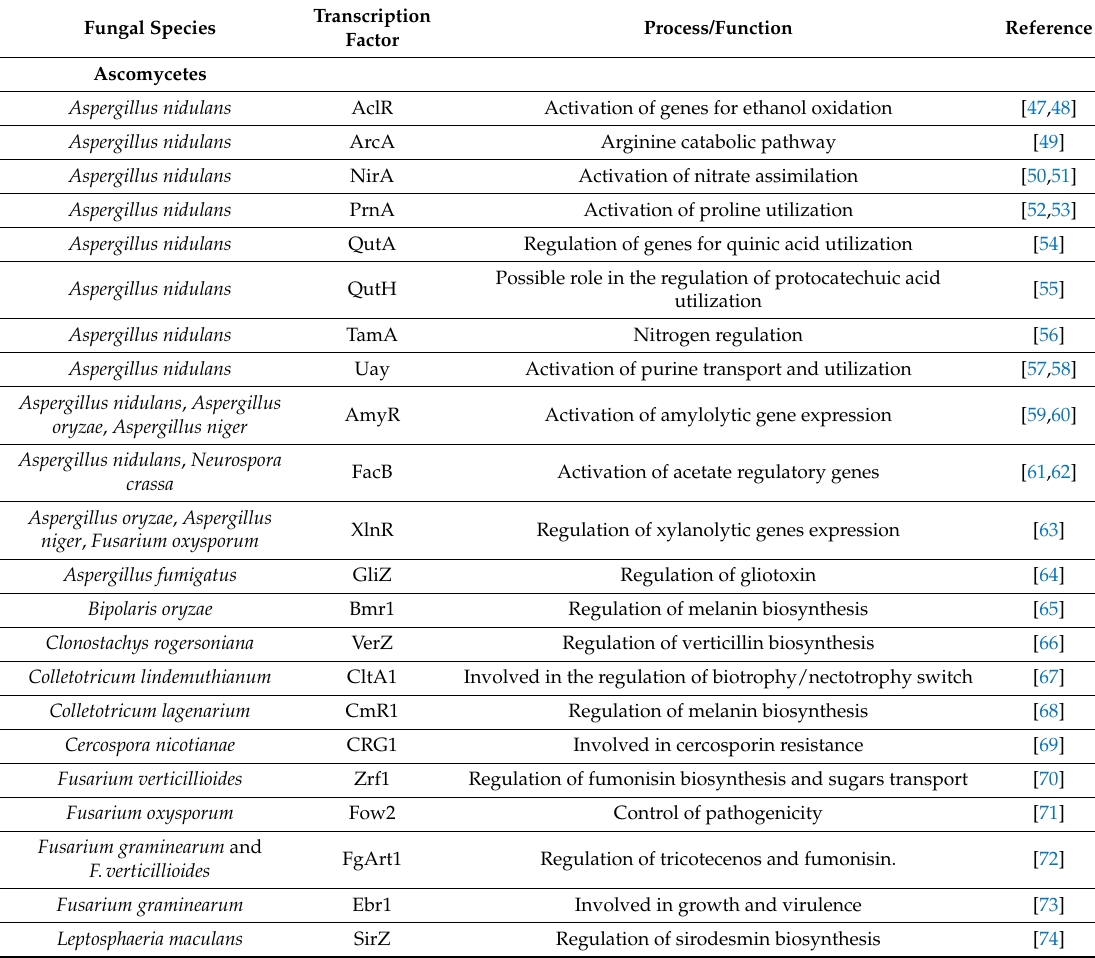
Table 2. Representative examples of class III zinc binding transcription factors (Zn 2 C 6 ) that have been characterized in filamentous